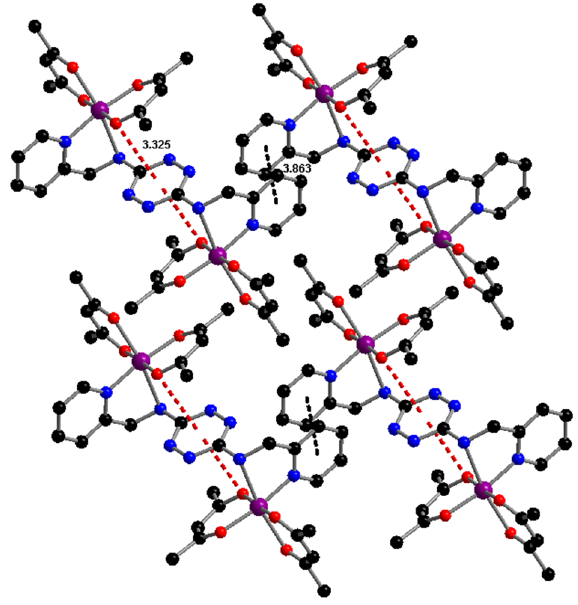
Figure 4. Intermolecular anion– π interactions between TTZ and oxygen atoms (red line) and π - π short distances between pyridyl rings (black line) in 3 . The hydrogen and fluorine atoms as well as the solvent molecules were omitted for clarity.